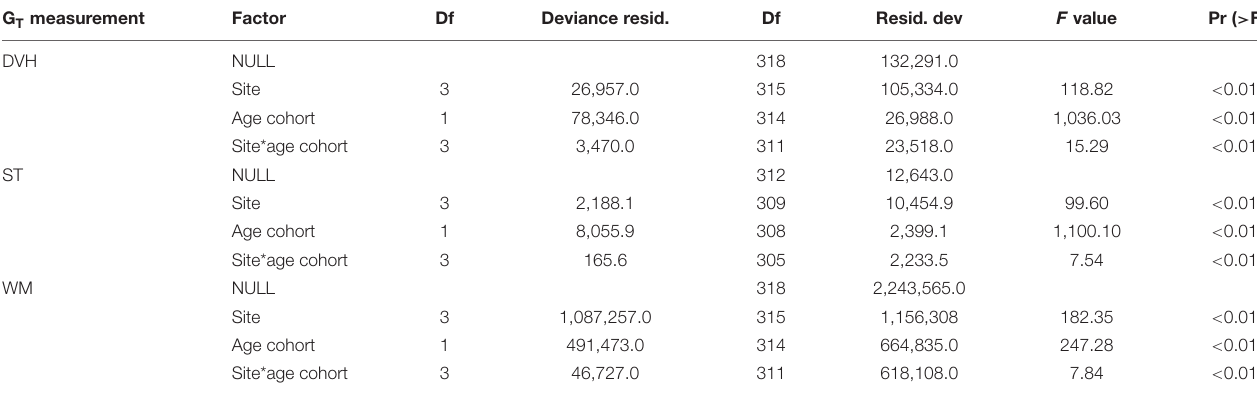
TABLE 2 | Outputs of generalized linear models of total growth (G T ) in dorso-ventral height (DVH), shell thickness (ST), and wet mass (WM) of Pteria penguin between sites and age cohorts.